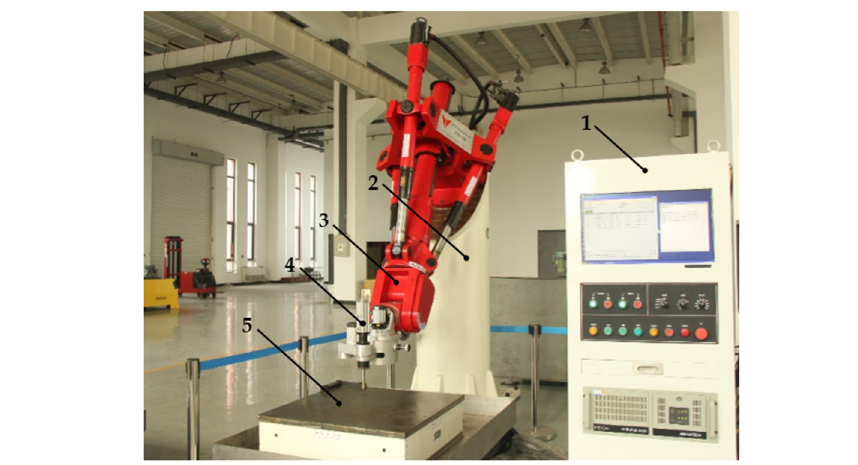
Figure 2. The prototype of the polishing robot.